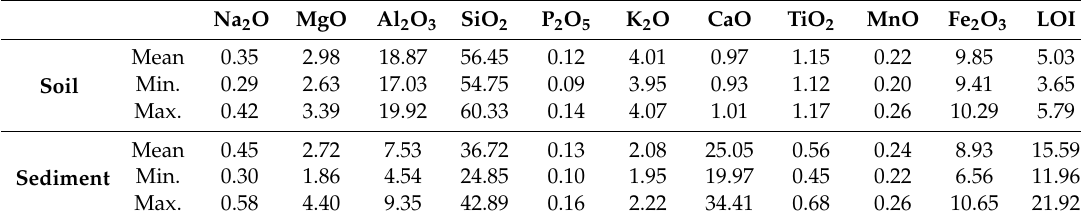
Table 2. Statistics of the main chemical composition for the studied samples